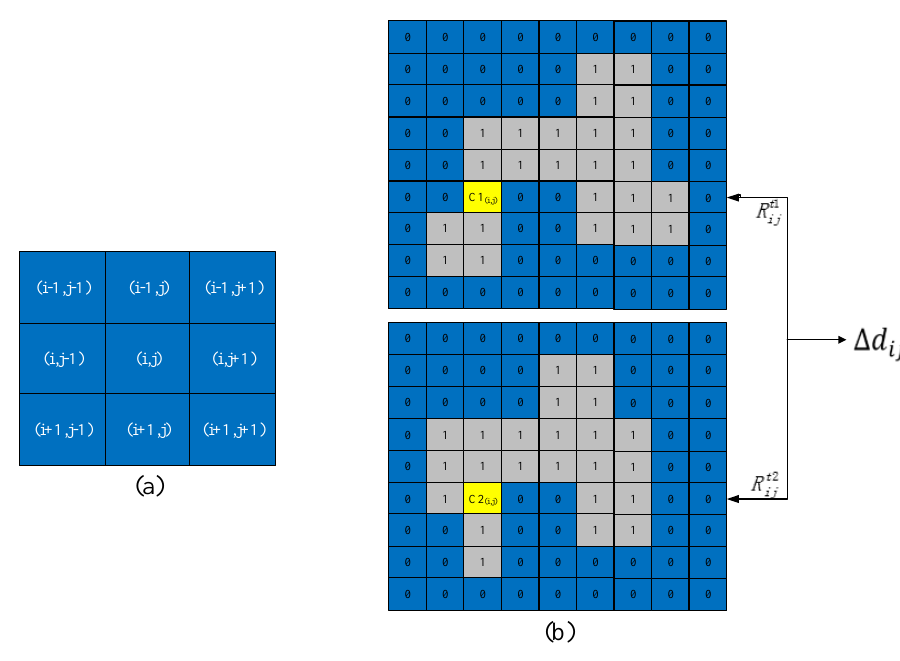
Figure 2. Examples of Adaptive Extended Regions: ( a ) An eight neighboring extension detector, and ( b ) the two regions labeled by “1” are the adaptive extended regions surrounding the central pixel C1 ( i,j ) and C2 ( i,j ) , respectively.